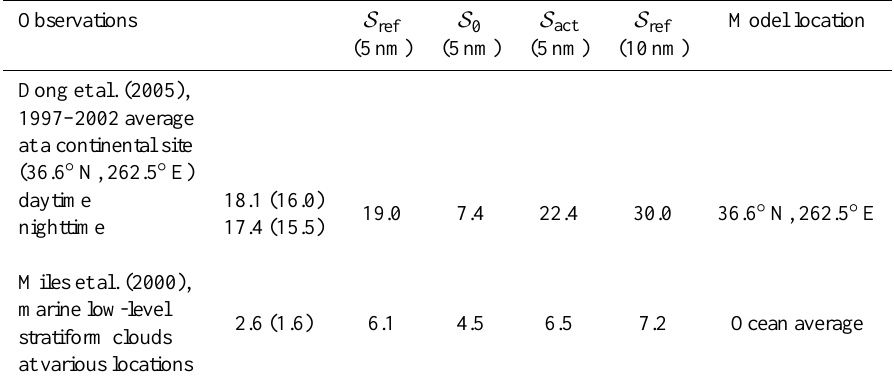
Table 5. Comparison of simulated annual mean cloud droplet burdens (in 10 10 m − 2 ), with 5 or 10nm maximum geometric mean diameter for the nucleation mode, with observations. Sample standard deviations calculated from the data in the referenced sources are given in